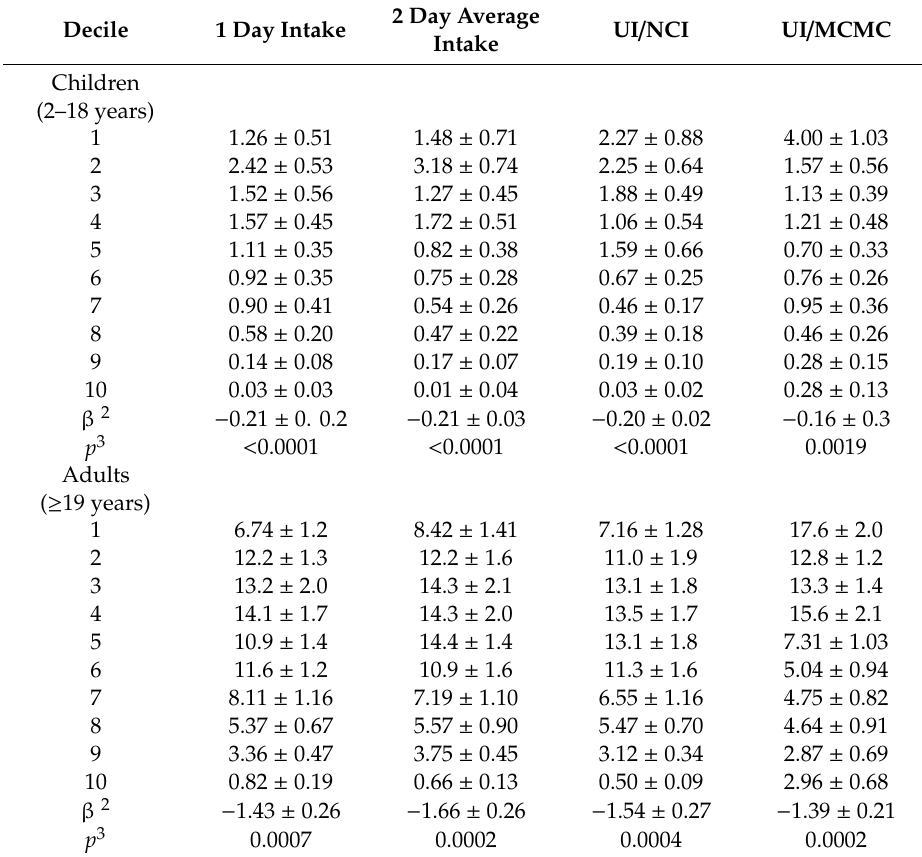
Table 4. Percentage of the population above the Adequate Intake of dietary fiber by deciles of added sugars intake by various methods, the NHANES 2011–2014.